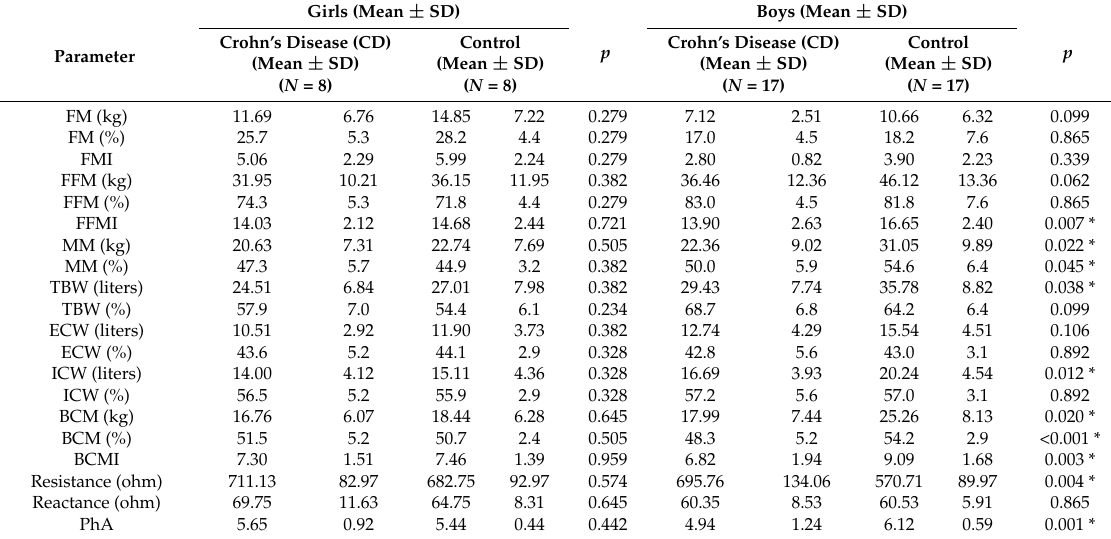
Table 4. BIA results in CD participants according to